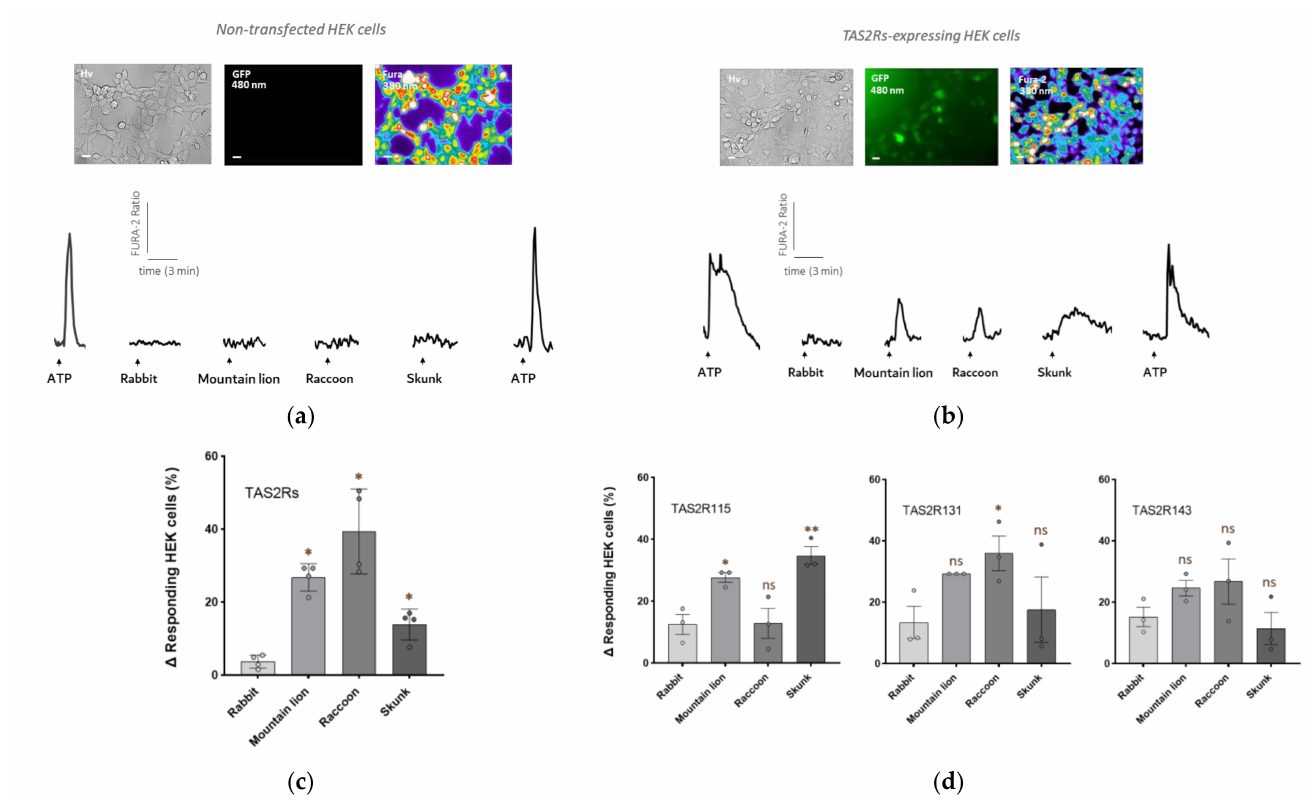
Figure 1. The urine of the racoon and the secretions from the anal glands of the skunk activate TAS2Rs-expressing HEK cells in an in vitro model. ( a , b ) Microscopic images of non-transfected HEK cells ( a ) and of TAS2Rs-transfected HEK cells ( b ) observed with a DIC contrast (Hv) at 480 nm (GFP) and at 380 nm after Fura-2 AM loading (Fura-2). Scale bars: 50 µ m. Representative examples of the intracellular calcium changes observed in one non-transfected cell ( a ) and in one transfected cell ( b ) in the presence of ATP (perfused to control the viability of the cells) or in the presence of the urines of the rabbit (non-predator), of the mountain lion (predator), of the raccoon (predator) and of the secretions from the anal glands of the skunk (predator). The Fura-2AM ratio is given in arbitrary units and time in minutes. Arrows indicate the perfusion times. ( c ) Graph representing the delta percentage of responding HEK cells obtained by subtracting the number of non-transfected cells (control) from the number of responses of the TAS2Rs-expressing cells. N = number of experiments for each cue, n = number of cells in total: control ( N = 4; n = 181); TAS2Rs ( N = 4; n = 184). Values are expressed as mean ± SEM; unpaired Student’s t -test or Mann–Whitney test used to compare the non-predator versus predators, * p < 0.05 (in brown). ( d ) Graph representing the delta percentage of responding HEK cells obtained by subtracting the number of non-transfected cells (control) to the number of responses of the TAS2Rs-expressing cells. N = number of experiments for each cue, n = number of cells in total: control ( N = 4; n = 181); TAS2R115 ( N = 3; n = 105); TAS2R131 ( N = 3, n = 123); TAS2R143 ( N = 3; n = 119). Values are expressed as mean ± SEM; unpaired Student’s t -test or Mann–Whitney test used to compare the non-predator versus predators, * p < 0.05; ** p < 0.01; ns, not significant (in